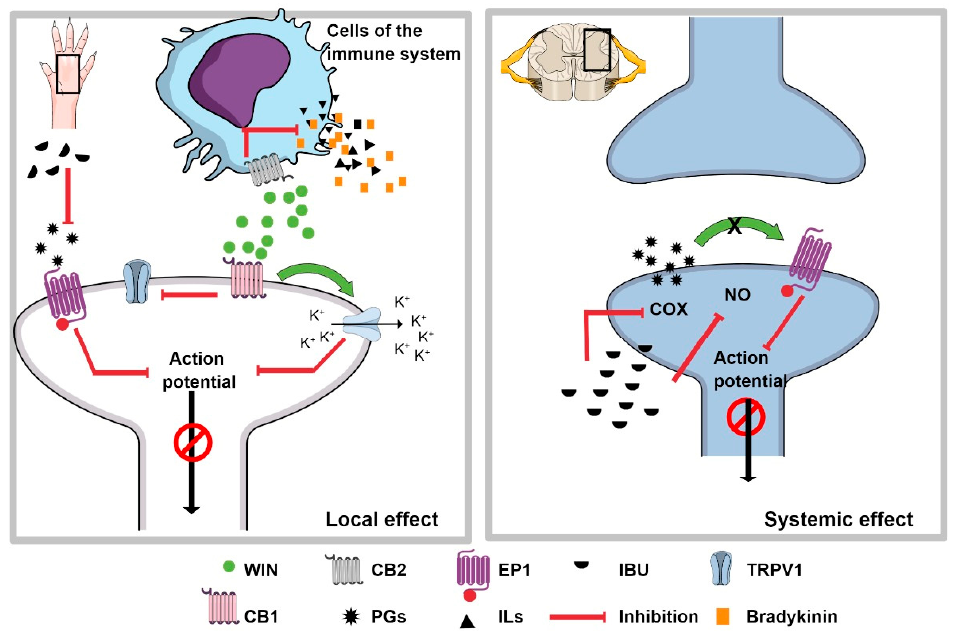
Figure 5. The synergism of IBU + WIN. The left side shows the possible mechanism of the local effect of WIN and IBU, the latter representing the inhibition of the synthesis of prostaglandins (PGs), which causes the non-sensitization of the nociceptor. In addition, when the CB2 receptor, located on immune system cells, is activated by WIN, it inhibits the release of pain and inflammatory mediators, which prevents nociceptor sensitization. When the CB1 receptor interacts with WIN, the βγ -dimer can open potassium channels to hyperpolarize the nociceptor. In addition, it can also inhibit the TRPV1 receptor. All of these events inhibit the nociceptive signal. The right inset represents the possible mechanism at the spinal level, where systemically administered IBU can inhibit the synthesis of PGs and nitric oxide (NO), which centrally inhibits the transmission of the nociceptive signal. These mechanisms would explain the synergism observed with the combination IBU + WIN administered systemically and locally, respectively.